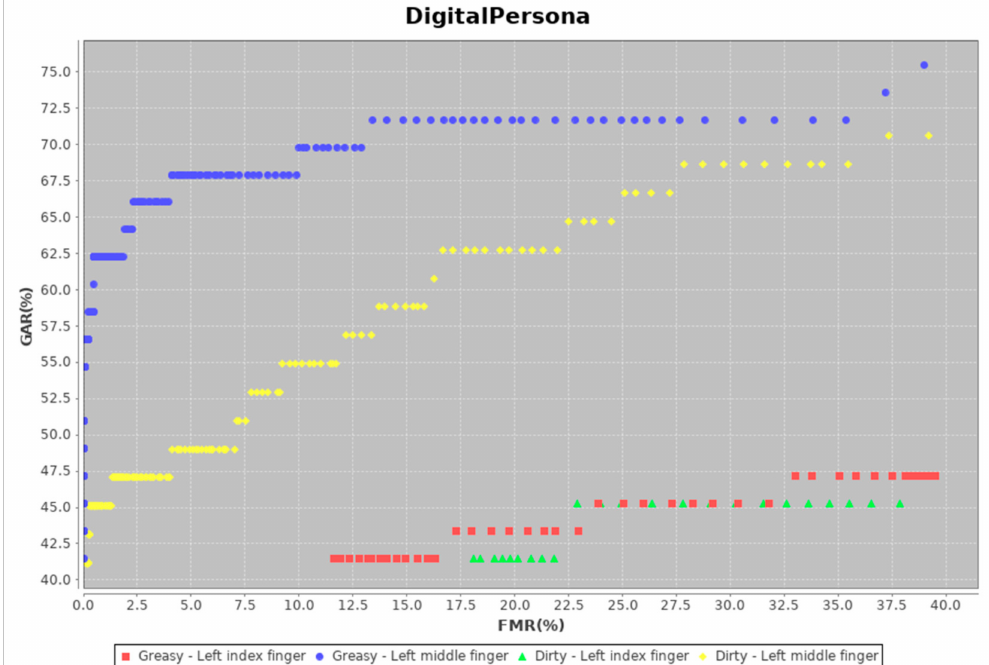
Figure 7. System performance ROC (Receiver Operating Characteristics)